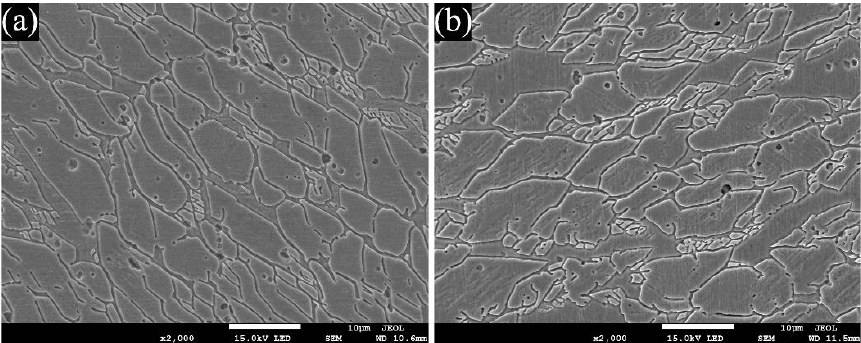
Figure 5. SEM images of the WM: ( a ) without ultrasonic treatment and ( b ) with ultrasonic treatment.